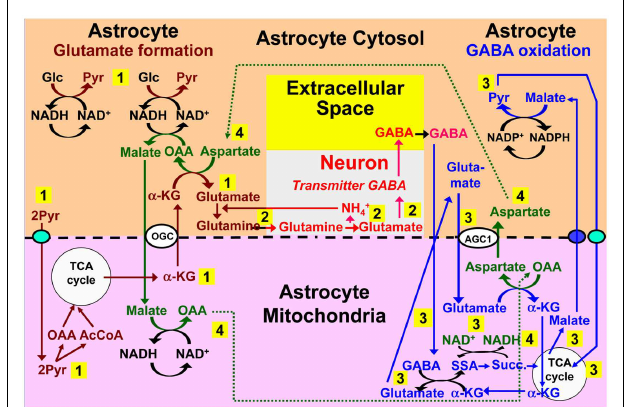
FIGURE 7 | Proposed model for cytosolic–mitochondrial trafficking associated with astrocytic production of glutamine (pathway 1), its transfer to GABAergic neurons (without indication of any extracellular space, because astrocyte-to-neuron transfer is the only major function for extracellular glutamine), neuronal GABA formation via glutamate (without details), and extracellular release as transmitter GABA (pathway 2), with subsequent reuptake of GABA and oxidative metabolism in astrocytes (pathway 3), and connections between pathways 1 and 3 shown as pathway 4 . Biosynthesis of glutamine is shown in brown and metabolic degradation of GABA in blue. GABA is suggested to enter the mitochondria in exchange with glutamate, although no such exchanger is presently known, and subsequently be transaminated to succinic-semialdehyde and oxidized to succinate. α -KG is initially used for the transamination, but later re-generated during metabolism of glutamate entering the mitochondria and metabolized as previously suggested for transmitter glutamate, with the mitochondrial malate extruder shown as a small purple oval. Redox shuttling and astrocytic release of glutamine and uptake of GABA are shown in black, and neuronal uptake of glutamine, followed by GABA formation and release in red. Reactions involving or resulting from transamination between aspartate and oxaloacetate (OAA) are shown in green. Note that (i) aralar activity is required not only for the initial production of each of two molecules of pyruvate (light blue oval in pathway 1), but also during the re-entry of glutamate into theTCA cycle and for the final entry of pyruvate into the mitochondria (light blue oval in pathway 3), (ii) all reactions are stoichiometrically accounted for, although only when GABA synthesis and oxidation are integrated. AGC1, aspartate/glutamate exchanger, aralar; α -KG, α -ketoglutarate; Glc, glucose; Pyr, pyruvate; OGC, malate/ α -ketoglutarate